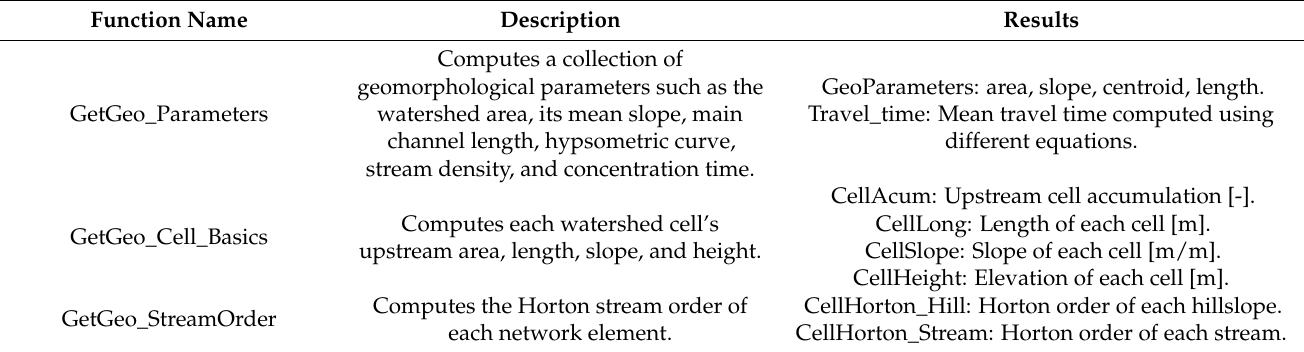
Table 2. Basin class basic geomorphological analysis function collection.